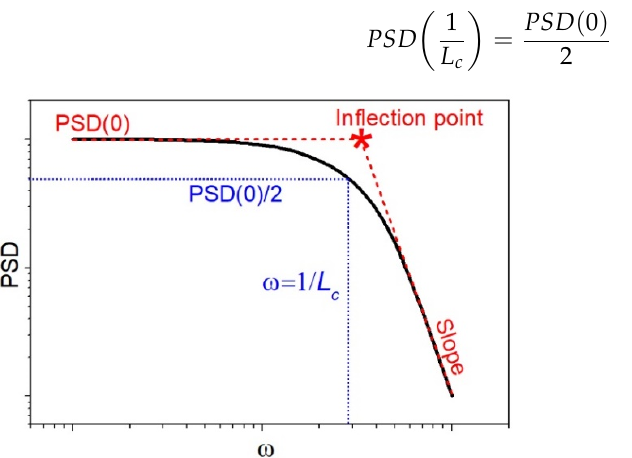
Figure 1. Schematic visualization of a typical PSD function of a randomized surface in a log-log scale. Low-frequency level ( PSD (0)), high-frequency sloped region and their infection point are denoted, as well as frequency corresponding to correlation length, L c .